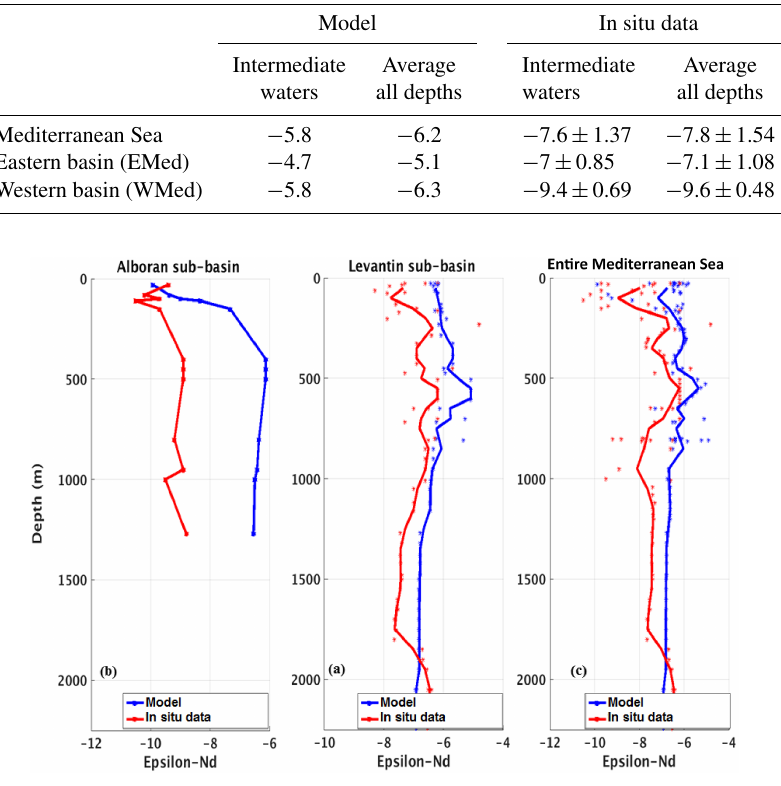
Figure 6. Comparison of average vertical profiles of Nd isotopic signature (Nd-IC) from EXP2 ( t = 3 months) in the whole Mediterranean Sea. Model results are in blue, while red indicates the in situ data from Tachikawa et al. (2004), Vance et al. (2004) and Henry et al.